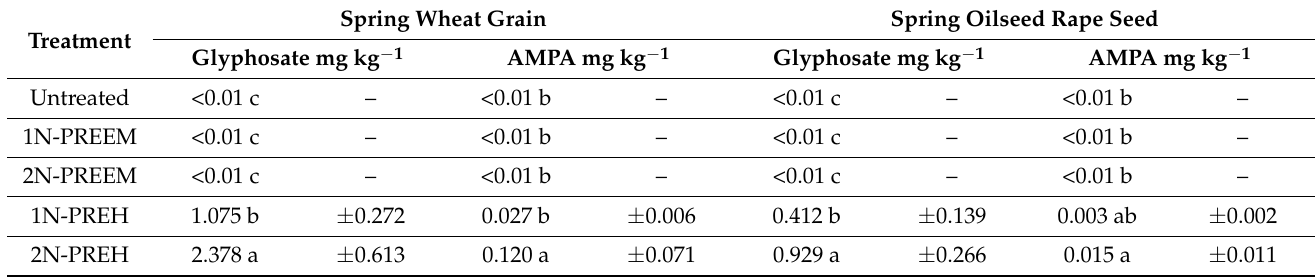
Table 2. Glyphosate and AMPA residues in harvested spring wheat grain and oilseed rape seeds,